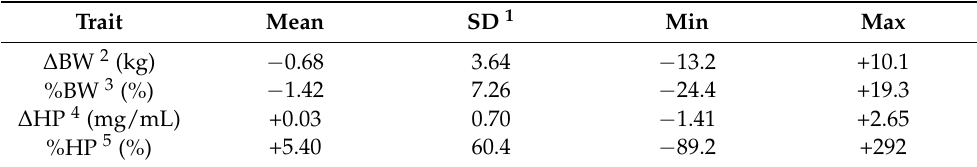
Table 2. Descriptive statistics for the resilience indicators in pigs from the experimental group. Trait